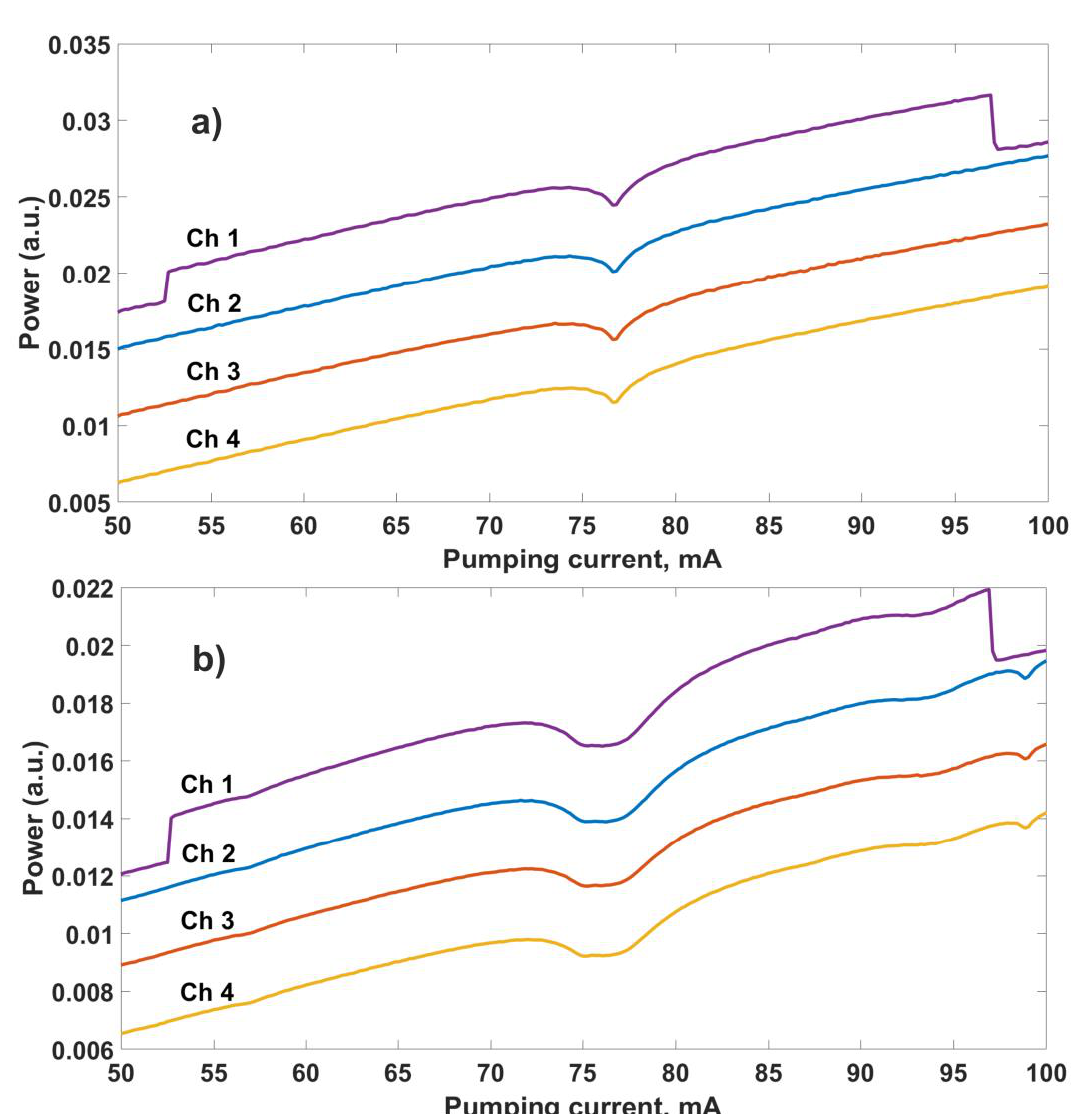
Figure 4. Raw data of the ground-based prototype of a multichannel laser heterodyne spectroradiometer (MLHS) in arbitrary power units. Ch 1–Ch 4 denote IF receiver numbers. ( a ) Raw data with the atmospheric CO 2 absorption line at 1605 nm; ( b ) raw data with the atmospheric CH 4 absorption line at 1651 nm.